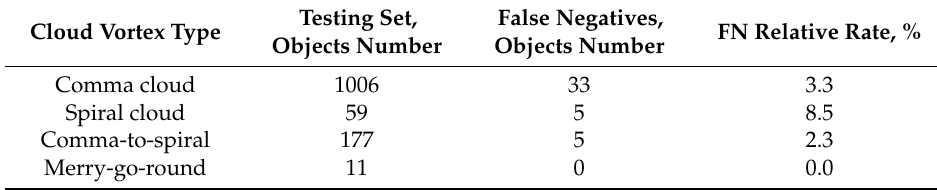
Table A3. False negative rates per cloud vortex types.